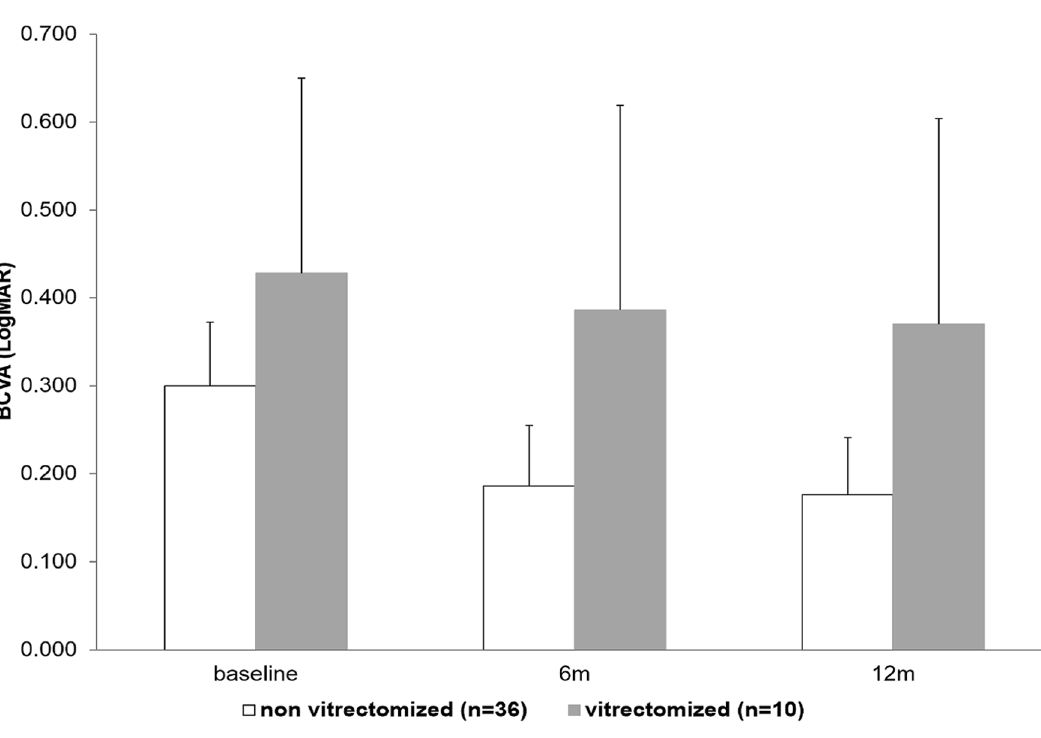
Figure 1. BCVA evolution from baseline to the end of follow-up. Mean ± 95% CI. p = ns at each time point using the Mann–Whitney U